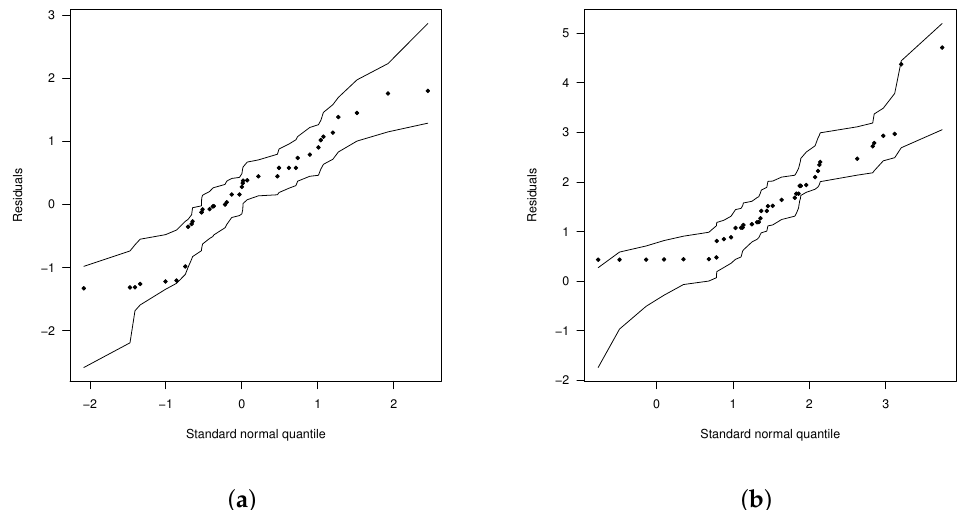
Figure 6. Normal probability plots for rMT i with envelopes of Q-qplots for the scaled residuals, from the fitted models. ( a ) ESHN and ( b ) EGSHN.